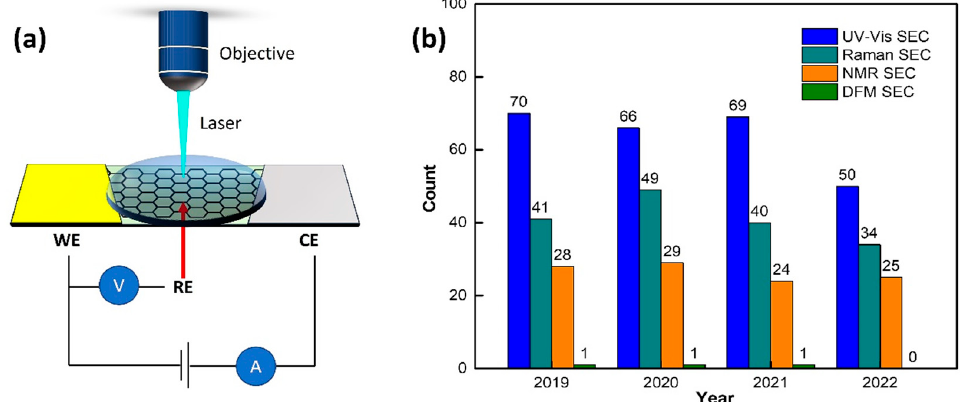
Figure 1. ( a ) Schematic diagram of a combination of electrochemistry and spectroscopy. ( b ) Histograms of statistical results for different spectroelectrochemistry (SEC)-related publications over the last six years. Relevant numbers are obtained from the website of the web of science by searching for “Ultraviolet–visible or UV-Vis; Spectroelectrochemistry”, “Raman spectroscopy; Spectroelectrochemistry”, “Nuclear Magnetic Resonance or NMR; Spectroelectrochemistry”, “Dark field microscopy or DFM; Spectroelectrochemistry.”.